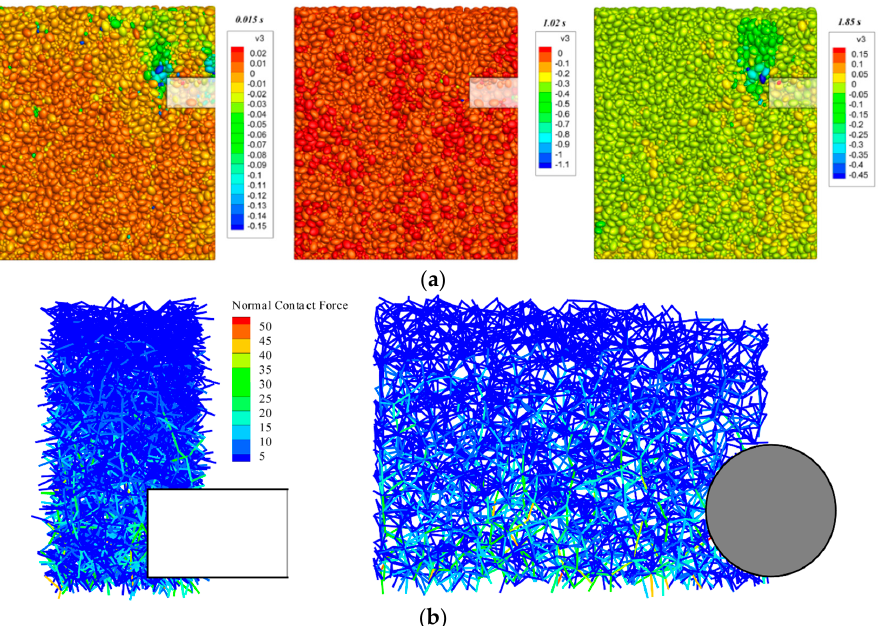
Figure 16. Micro-structure evolution during tunnel face collapse under C / D = 2.0: ( a ) Particle speed distribution; and ( b ) distribution of the force chain while the tunnel face is collapsing.